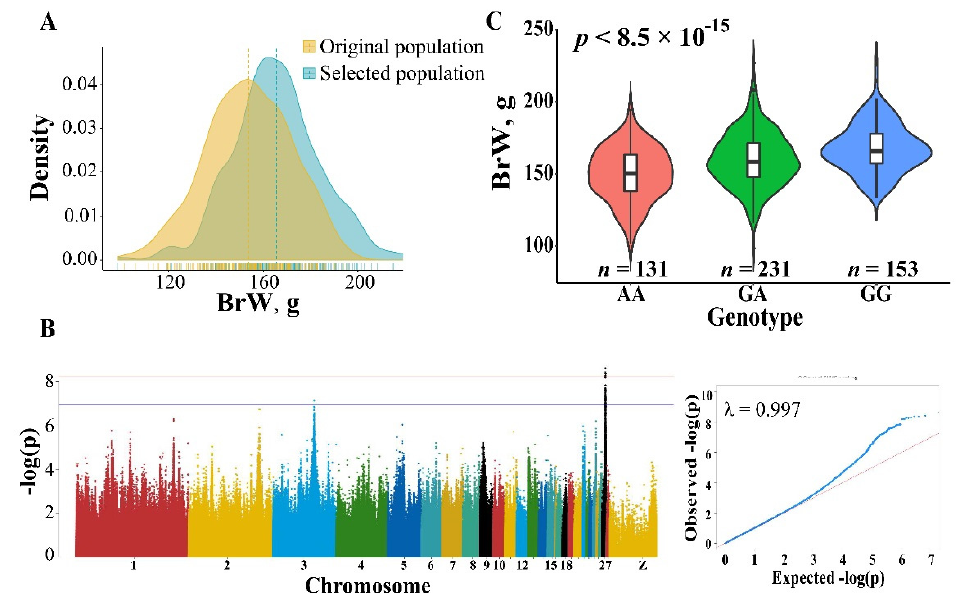
Figure 4. Phenotypic difference and GWAS result for BrW. ( A ) Comparison for BrW in original and selected population. ( B ) Manhattan and quantile-quantile plot for BrW. A significant region was identified in chromosome 27 (the black dots). The horizontal red and blue lines represent the genome-wide and suggestive significance, respectively. ( C ) The effect of the lead SNP chr27_6115361 on BrW, the p value was calculated using GLM. Table 1. Candidate genes in the significant region of chromosome 3 and 27.